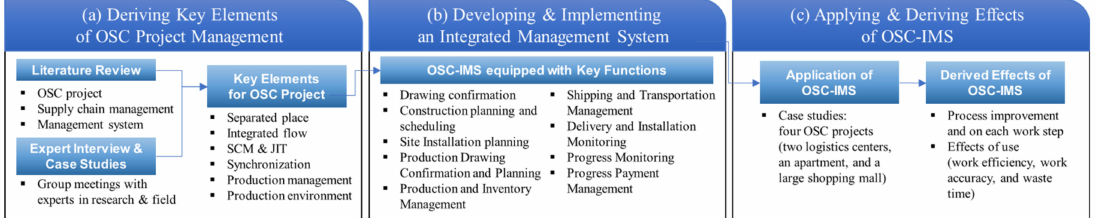
Figure 1. Research